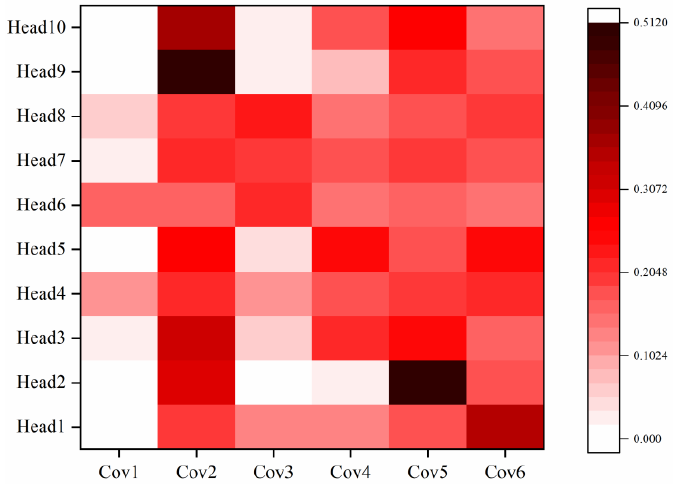
Figure 10. Heat map of second layer attention weighting results.